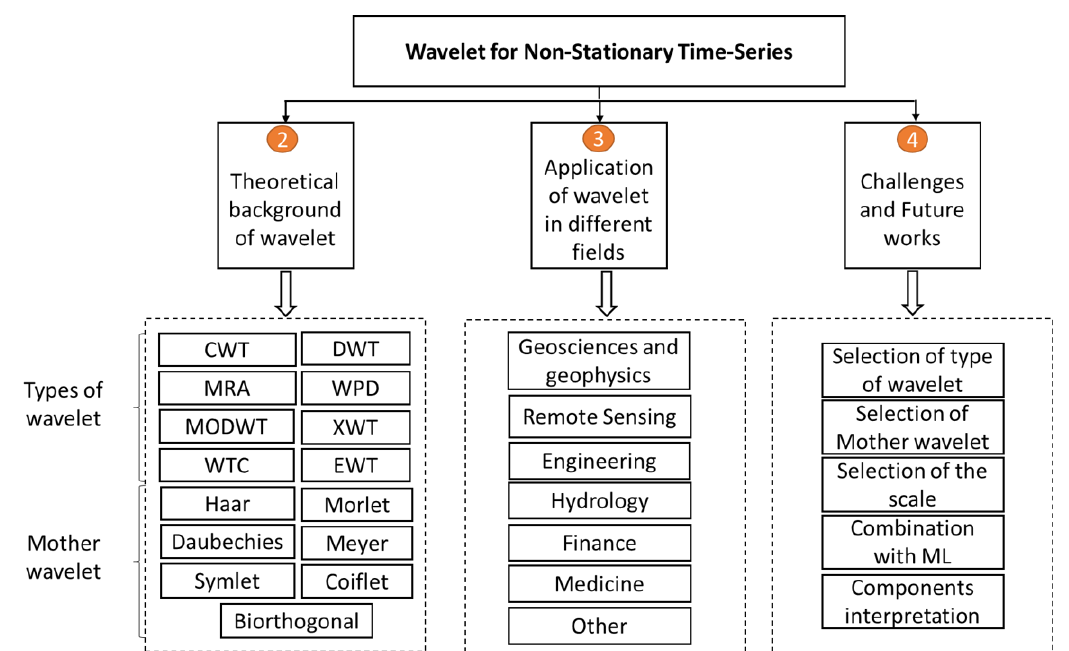
Figure 1. Simplified workflow of the different aspects included in the wavelet